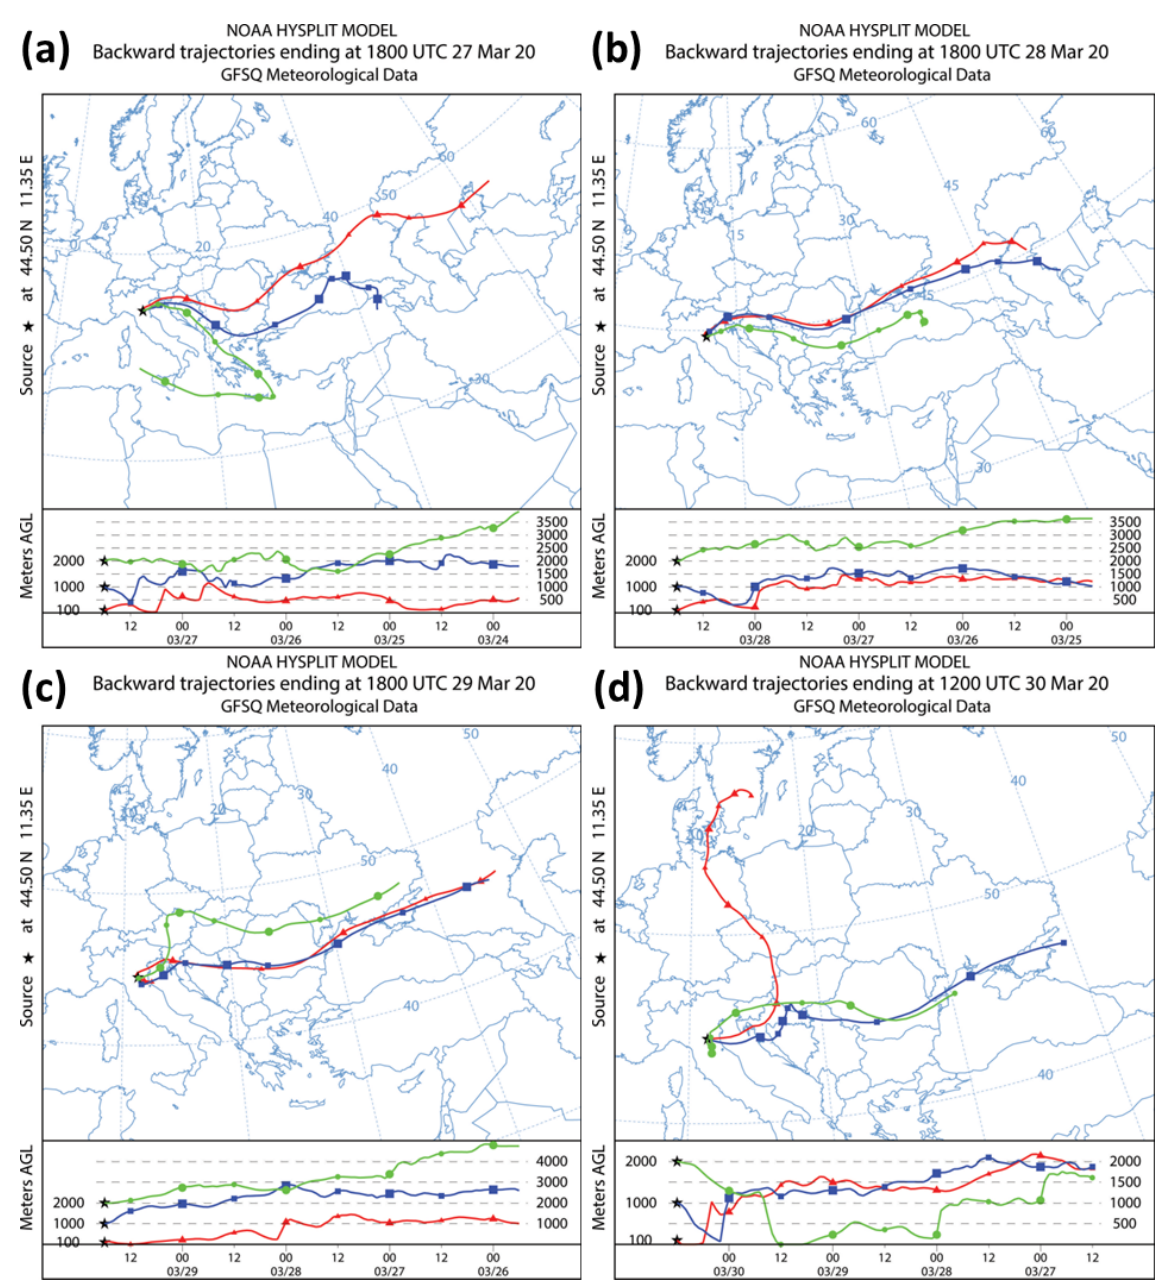
Figure 3. Back trajectories (96h backwards) ending at Bologna on (a) 27 March at 18:00UTC, (b) 28 March at 18:00UTC, (c) 29 March at 18:00UTC, and (d) 30 March at